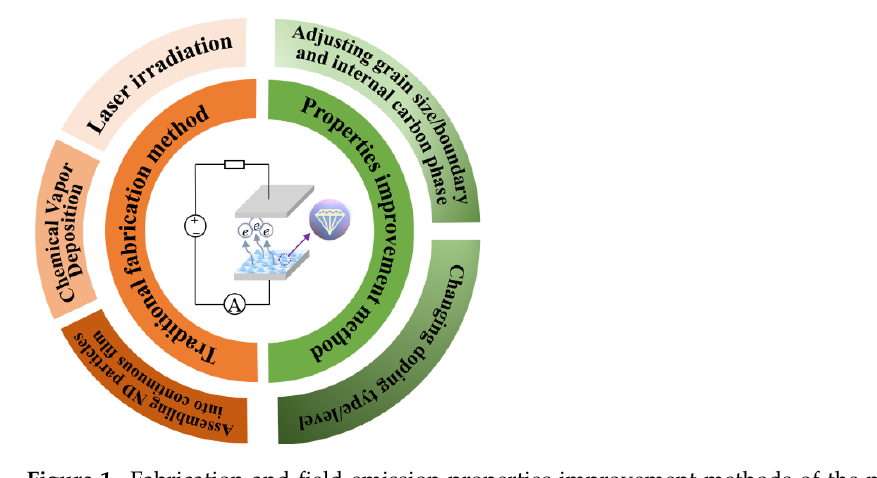
Figure 1. Fabrication and field emission properties improvement methods of the nanodiamond (ND) films.